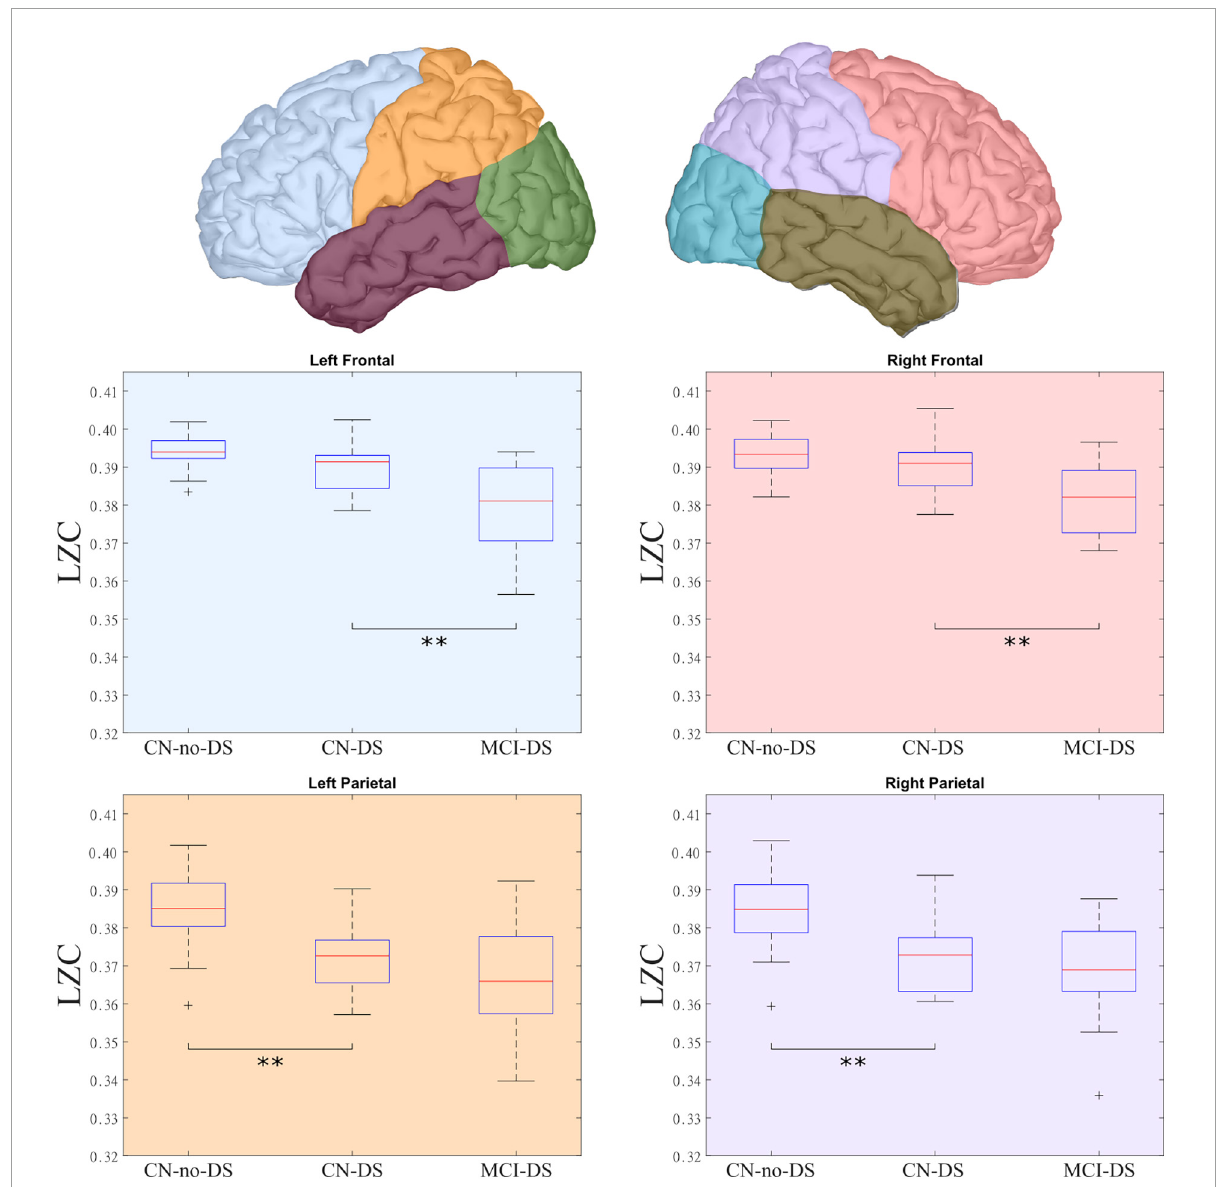
FIGURE1 LZC distribution across groups and lobes. The top panel presents the lobes that presented significant differences in complexity among the groups. The bottom panel details these differences, showing the groups with significant differences in each lobe. The MCI-DS group showed the lowest complexity values, while the CN-DS group exhibited intermediate scores when compared with the CN-no-DS group. CN, control; DS, Down syndrome; LZC, Lempel-Ziv complexity; MCI, mild cognitive impairment. **Statistically significant difference between two